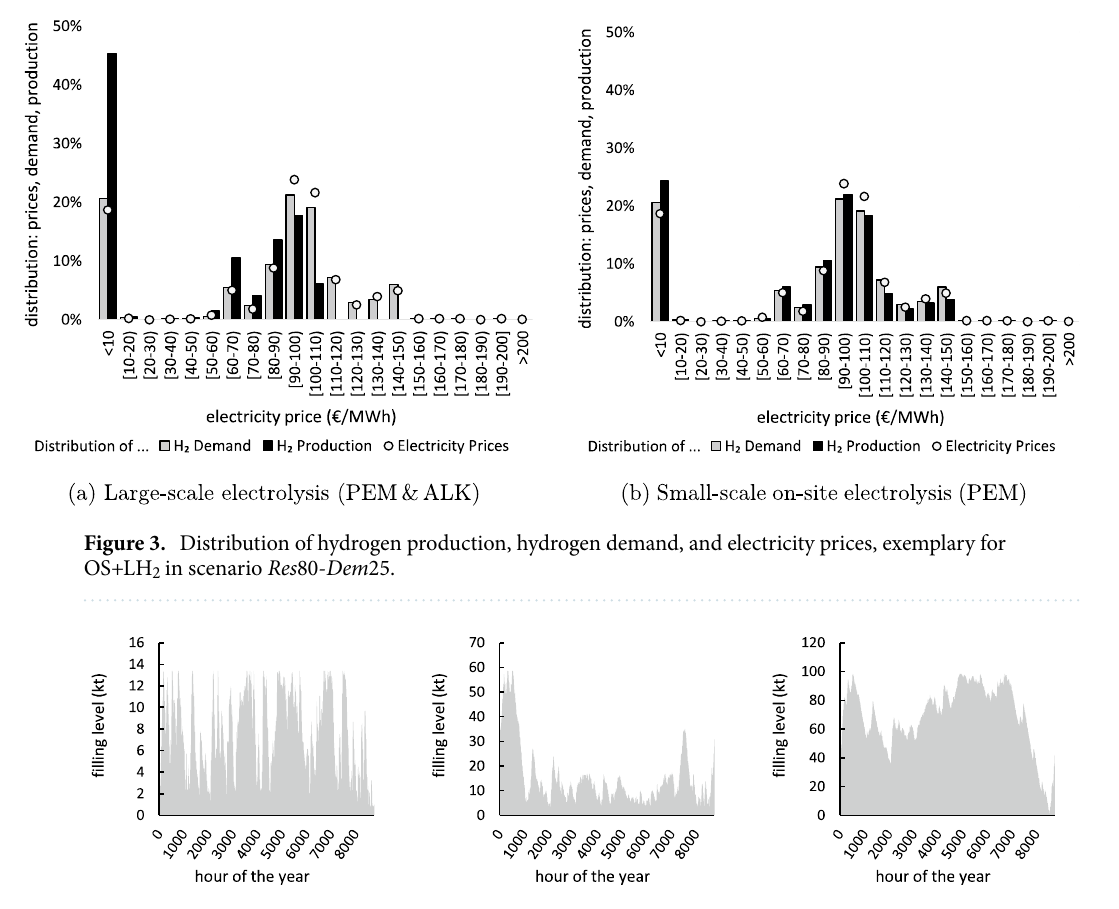
Figure 4. Temporal use pattern of production-site storage in scenario Res 80- Dem